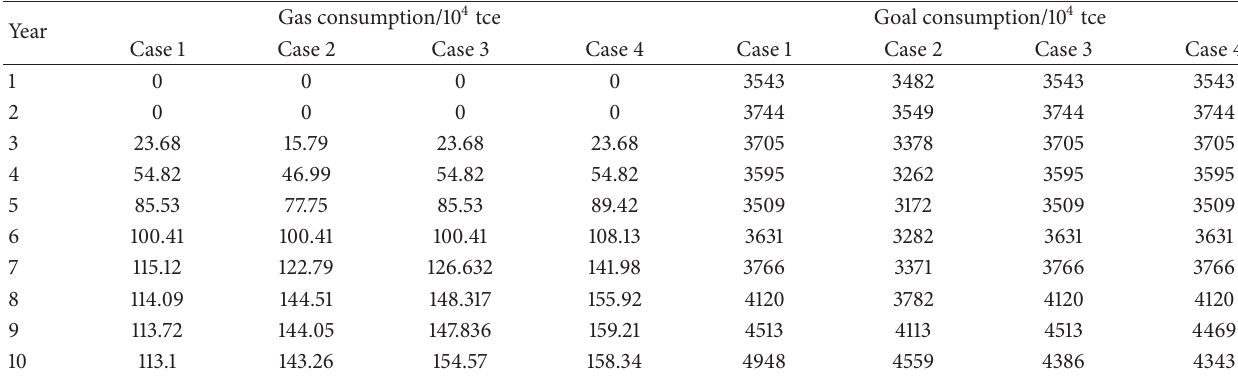
Table 18: Fuel consumption in 4